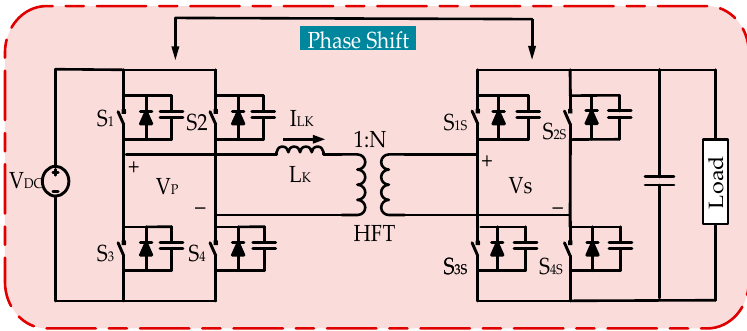
Figure 4. The traditional DAB